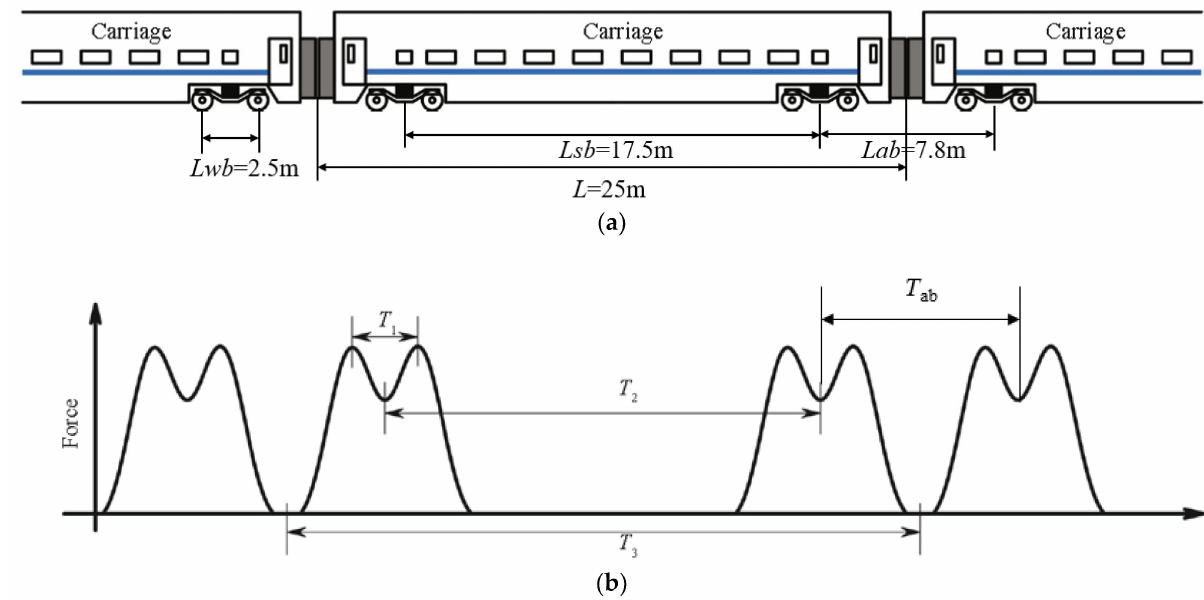
Figure 3. Geometry configuration of the high-speed trains and M-shaped wave. ( a ) Geometry configuration of the high-speed trains; ( b ) M-shaped